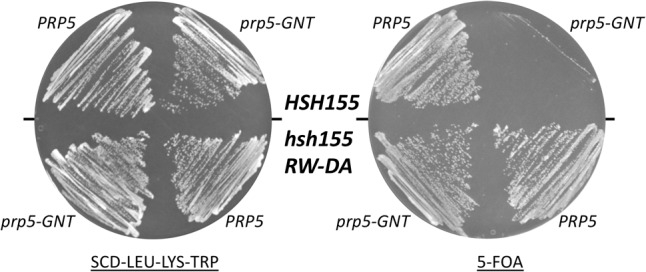
Disruption of the interaction between the UHM of Cus2 and the ULM of Hsh155 bypasses the essential ATP-dependent function of Prp5. The ULM of Hsh155 was mutated (R100D, W101A) in yeast strain DS4D (prp5Δ, cus2Δ, u2Δ; Perriman et al. 2003) harboring pRS317-CUS2, pRS315-U2, and pRS316-PRP5. The wild-type and hsh155RW-DA mutant strains were then transformed with pRS314-prp5-GNT (left) and then plated on medium containing 5-FOA (right) to select for cells able to lose the pRS316-PRP5 plasmid.